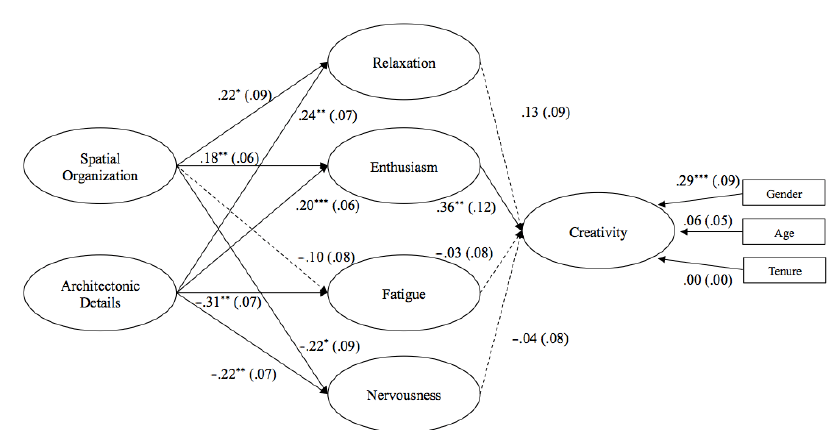
Figure 2. Model results of spatial organization, architectonic details and creativity through activated and deactivated mood (source: created by